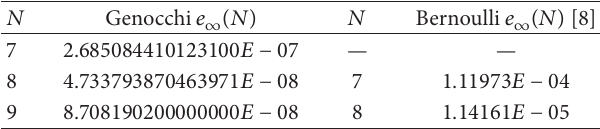
Table 5: Comparison of 𝐿 ∞ error for Example 3 using 𝑁 = 7, 8, 9 orders of Genocchi polynomials and that of Bernoulli method